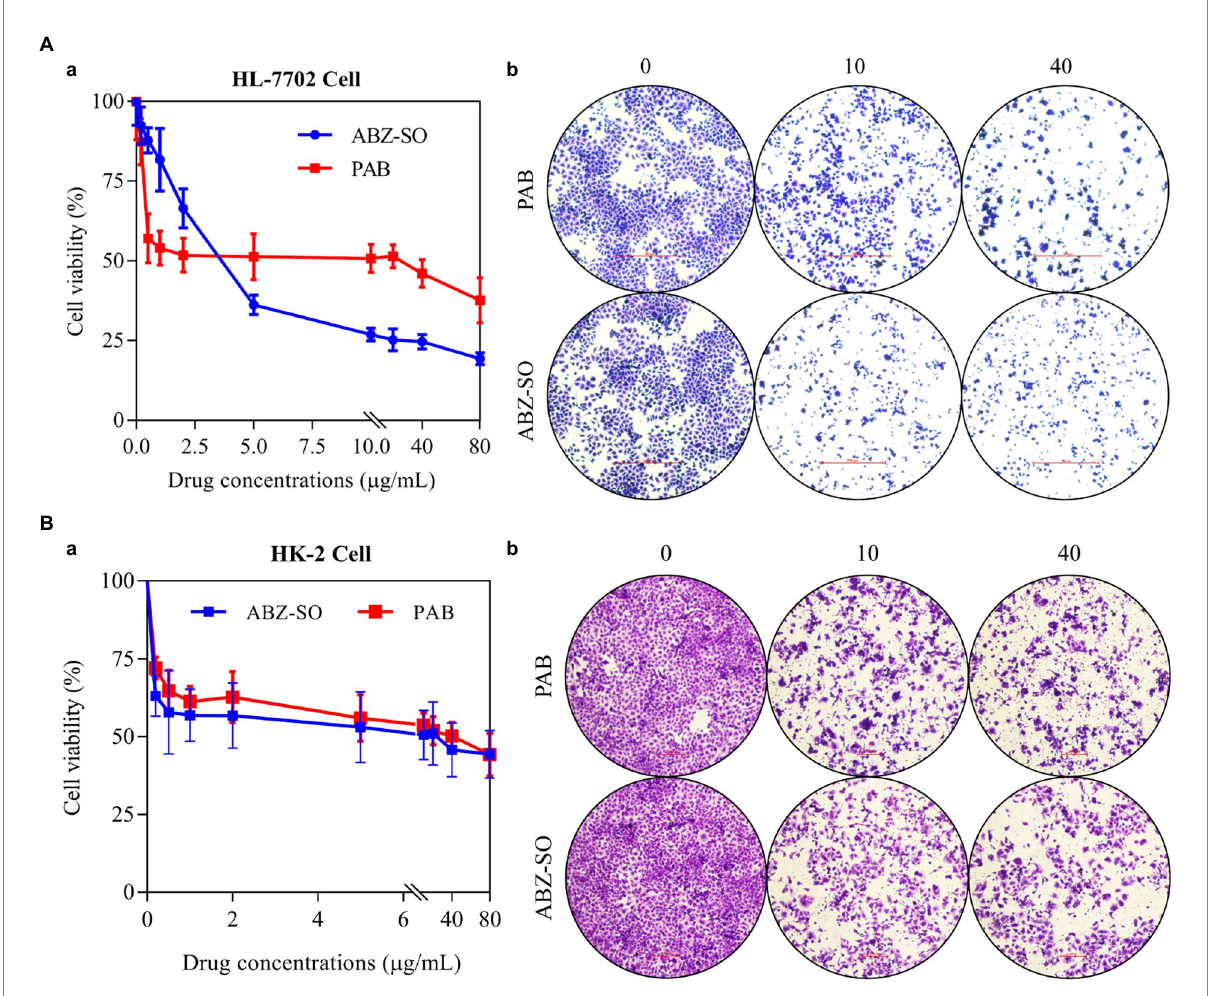
FIGURE 7 Cytotoxicity of PAB on human hepatocytes and renal cells in vitro . The cell livability (a) and number (b) of HL-7702 cell (A) and HK-2 cell (B) after treatment with different concentrations of PAB and ABZ-SO (0–80 μ g/ml) for 48 h by CCK-8 assay (A) and crystal violet staining (B) . The independent experiments were processed in